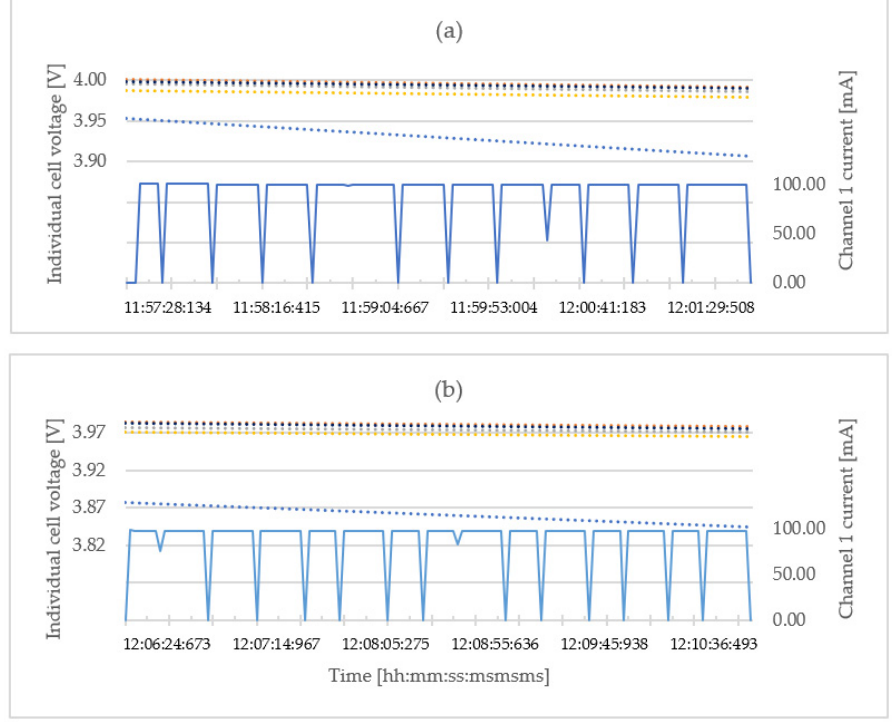
Figure 16. Initial ( a ) and final ( b ) battery-cell voltage (trendlines) and balancing channels current oscillograms in the de-balance system configuration.